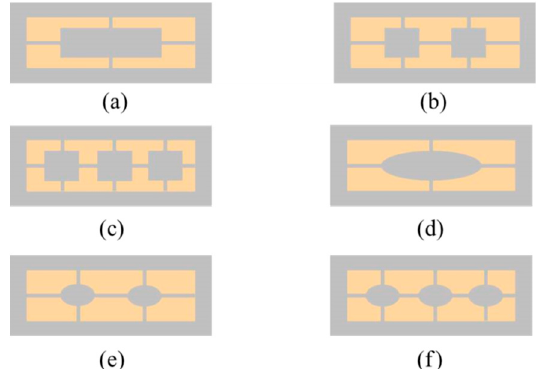
Figure 3. Top-view sketch of the six ESCSs, ( a ) one rectangular column (RC), ( b ) two RCs, ( c ) three RCs, ( d ) one ellipse column (EC), ( e ) two ECs, and ( f ) three ECs.